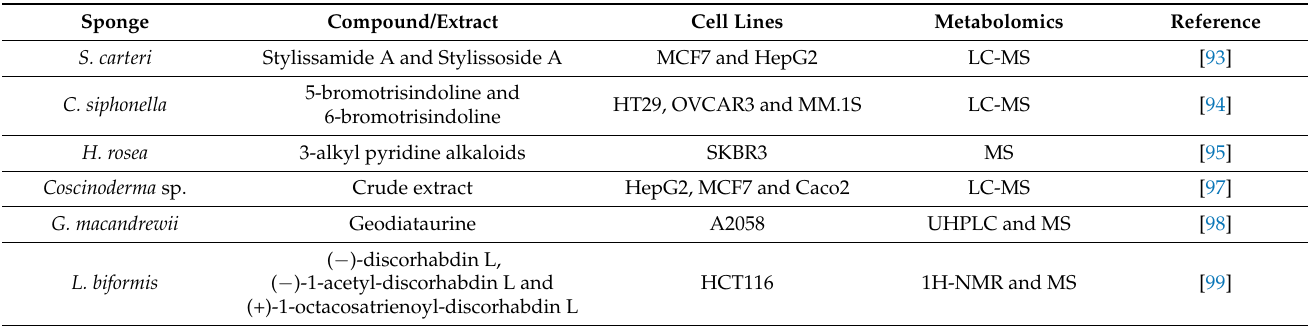
Table 1. Sponge species, compound/extract, cell lines tested, metabolomics techniques and corre- sponding reference are